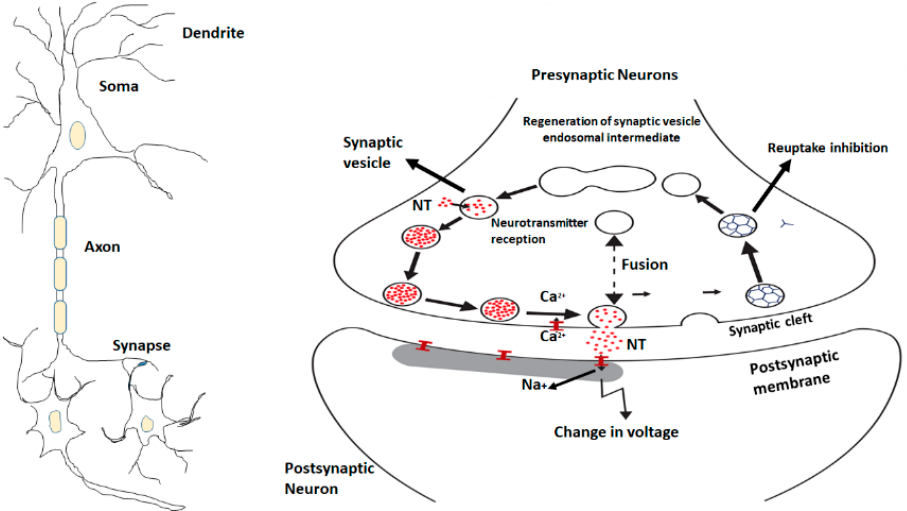
Figure 2. The neuronal signaling pathway and the movement of neurotransmitters through synaptic vesicles.